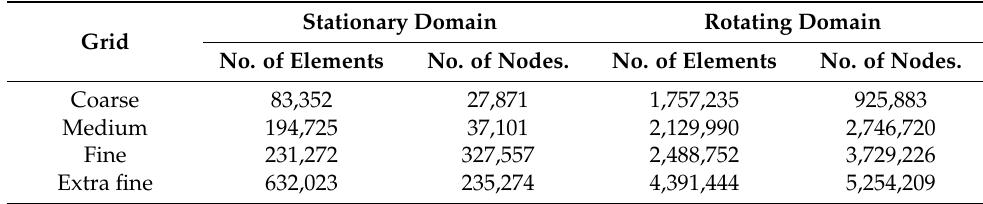
Table 1. The grid independence statistics for the S-ORM model. Grid